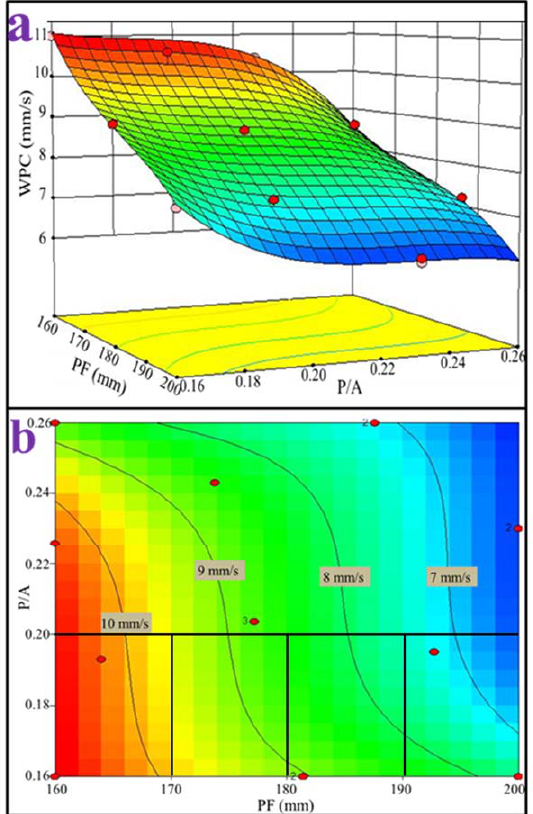
Figure 9. ( a ) Response surface and ( b ) contour line of WPC versus PF and P/A ratio. The red circles in the figure are experimental data points.